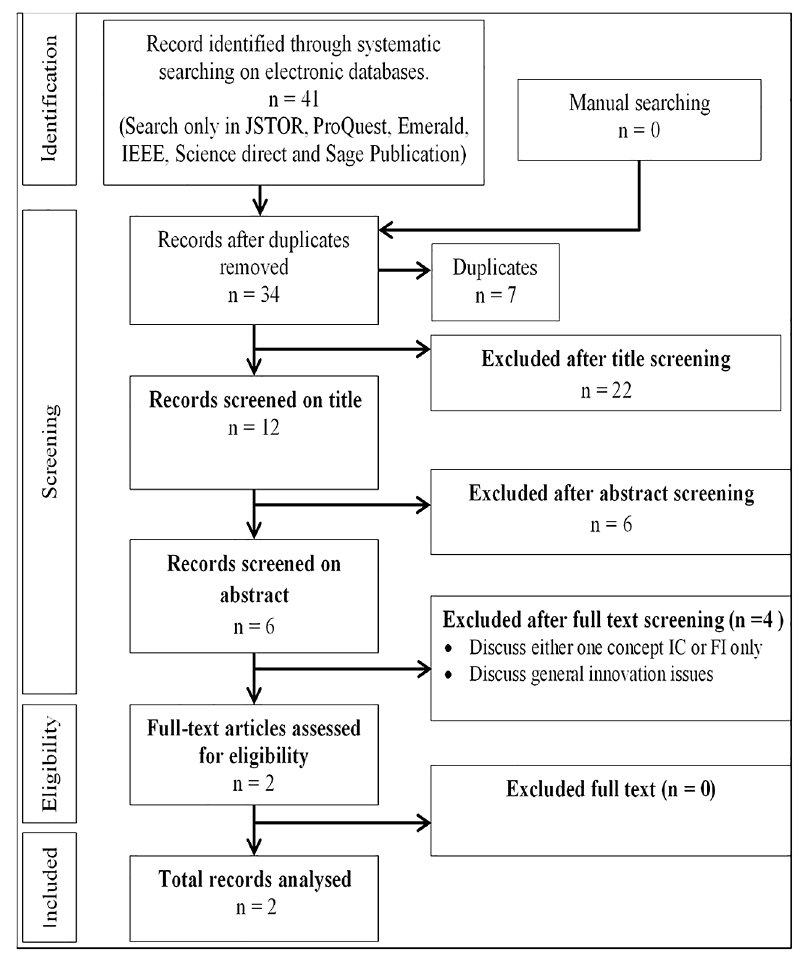
Figure 3. PRISMA extraction